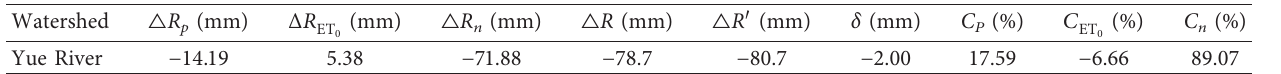
Table 2: Attribution of runoff change in the Yue River watershed.